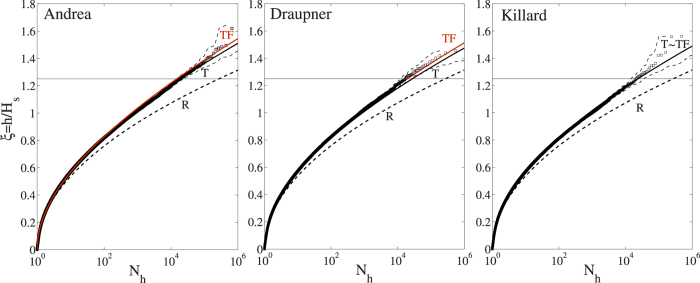
Crest height scaled by the significant wave height (ξ) versus conditional return period (Nh) for the (left) Andrea, (center) Draupner and (right) Killard rogue sea states: HOS numerical predictions (◻) in comparison with theoretical models (T = second-order Tayfun (light solid lines), TF = third-order (red solid lines) and R = Rayleigh distributions (dark dashes)).Confidence bands are also shown (light dashes). Nh(ξ) is the inverse of the exceedance probability P(ξ) = Pr[h > ξHs]. Horizontal lines denote the rogue threshold 1.25Hs2.